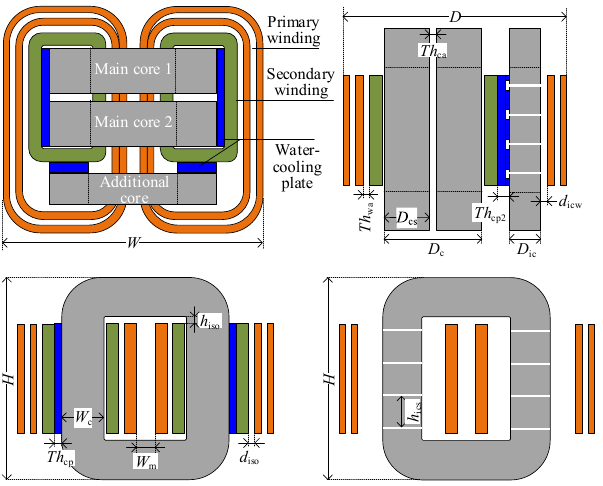
Figure 18. Sketch of the CW ELII MFT structure.